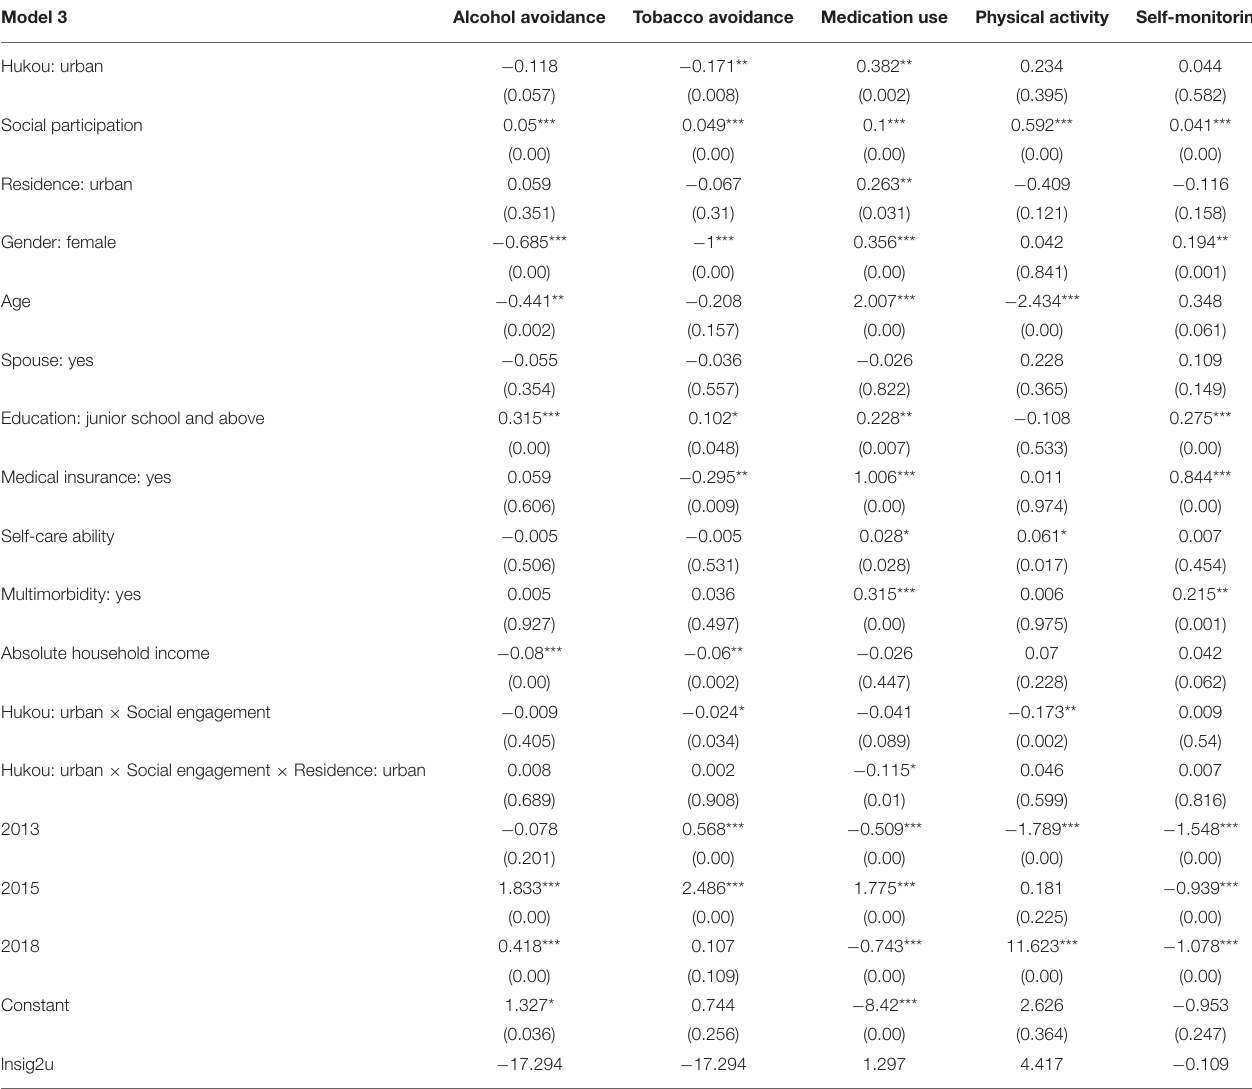
TABLE 6 | Random-effect panel logit regressions reporting the role of population mobility for the effect of social engagement on urban-rural disparities of self-management behaviors. Model